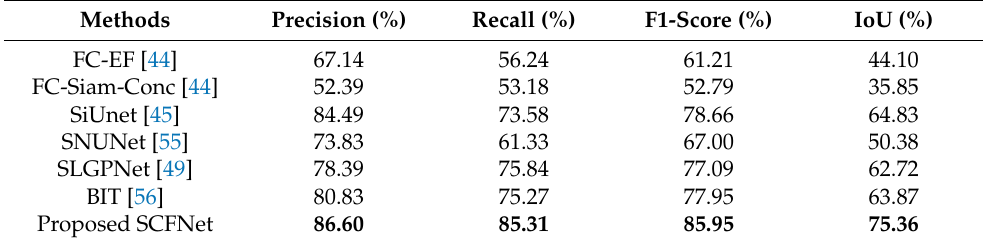
Figure 6. The confusion matrices of the results of the proposed SCFNet on two data sets. ( a ) Wenzhou data set; and ( b ) Guangzhou data set. Table 1. Quantitative comparison of different methods on the Wenzhou data